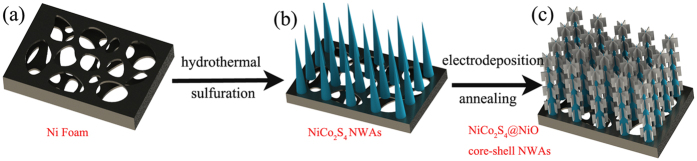
Schematic illustrating the formation process of the NiCo2S4@NiO NWAs on Ni foam.(a) Ni foam, (b) NiCo2S4 NWAs, (c) NiCo2S4@NiO NWAs.